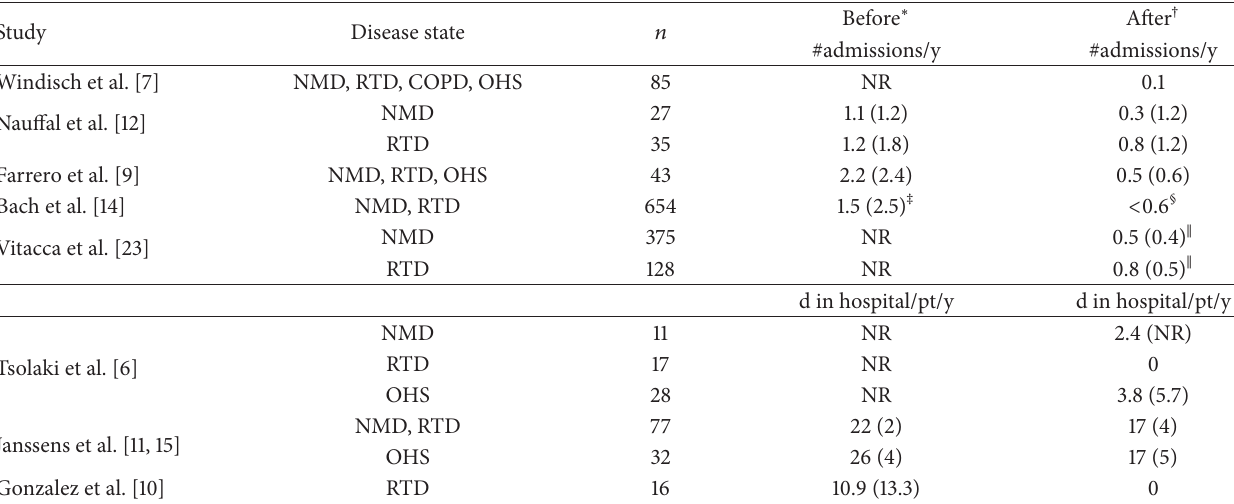
Table 4: Hospitalization rates before and after